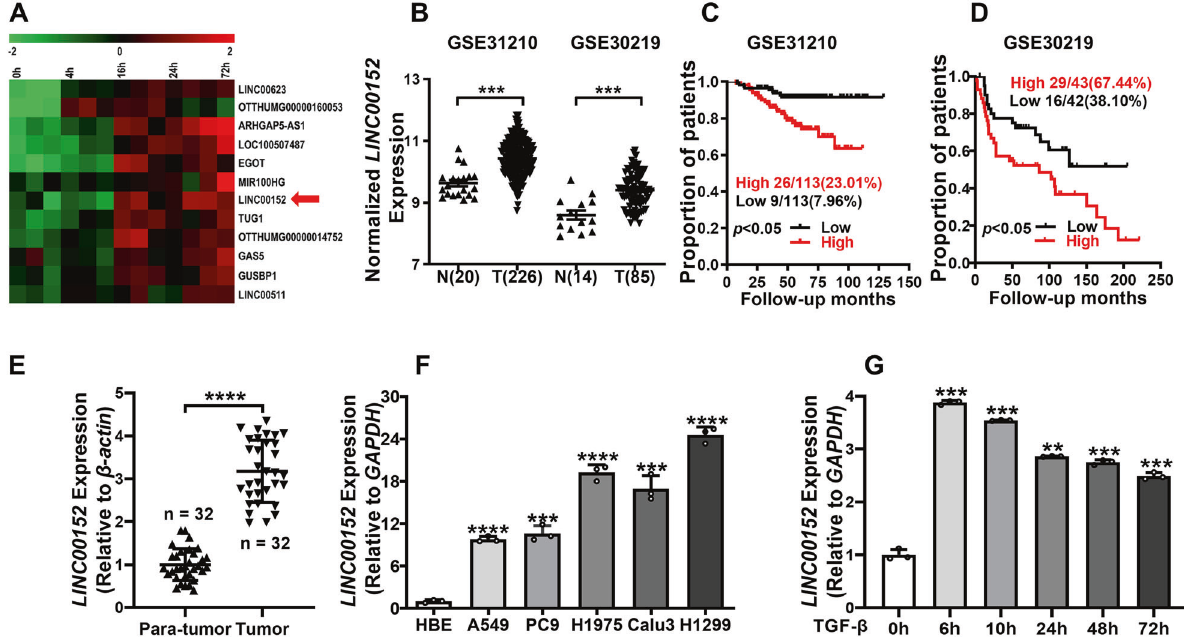
Fig. 1 LINC00152 is overexpression in LUAD as a TGF- β induced LncRNA. A The heat maps of the 12 LncRNAs expression in A549 cells induced by TGF- β at different time points. B LINC00152 expression in human LUAD tissue samples and adjacent lung tissue samples from GSE31210 and GSE30219 data. C , D Kaplan – Meier survival analysis of LUAD dataset for overall survival from GSE31210 and GSE30219 data. Each cohort was divided into LINC00152 high (red) and low (black). E LINC00152 expression was analyzed by RT-qPCR in matched tumor samples compared with para-tumor samples ( n = 32). F The expression of LINC00152 in LUAD cells compared to human bronchial epithelial (HBE) cells. G A549 cells were treated with TGF- β (5 ng/mL) at different times and the expression of LINC00152 was detected by RT-qPCR.